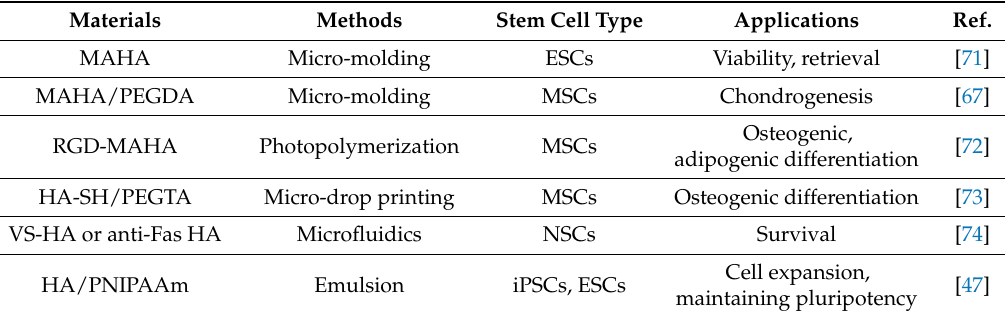
Table 2. Examples of hyaluronic acid-based stem cell